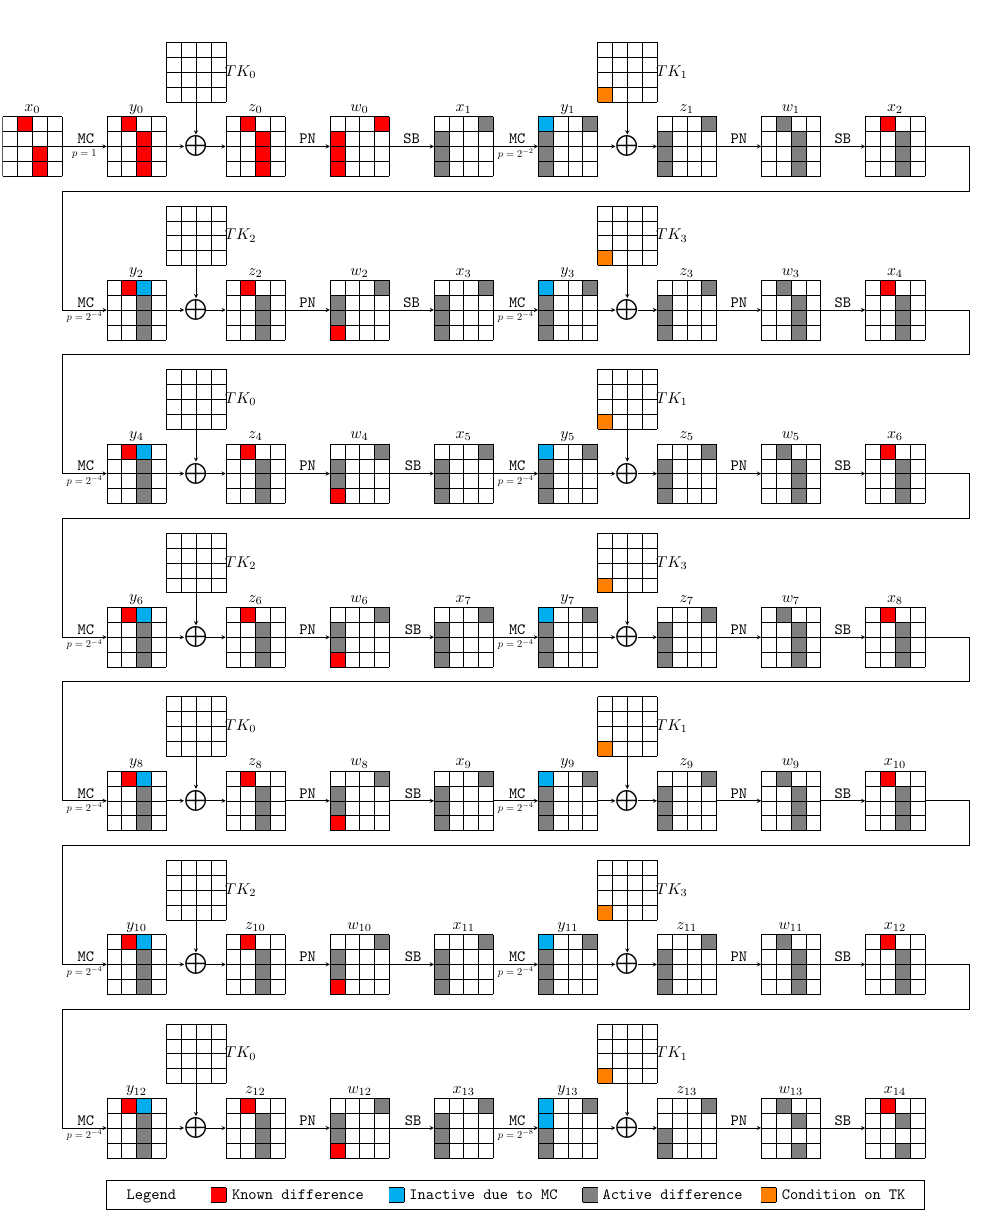
Figure 5: A 14-round truncated differential trail of CRAFT with probability 2 − 2 − 4 × 13 = 2 − 54